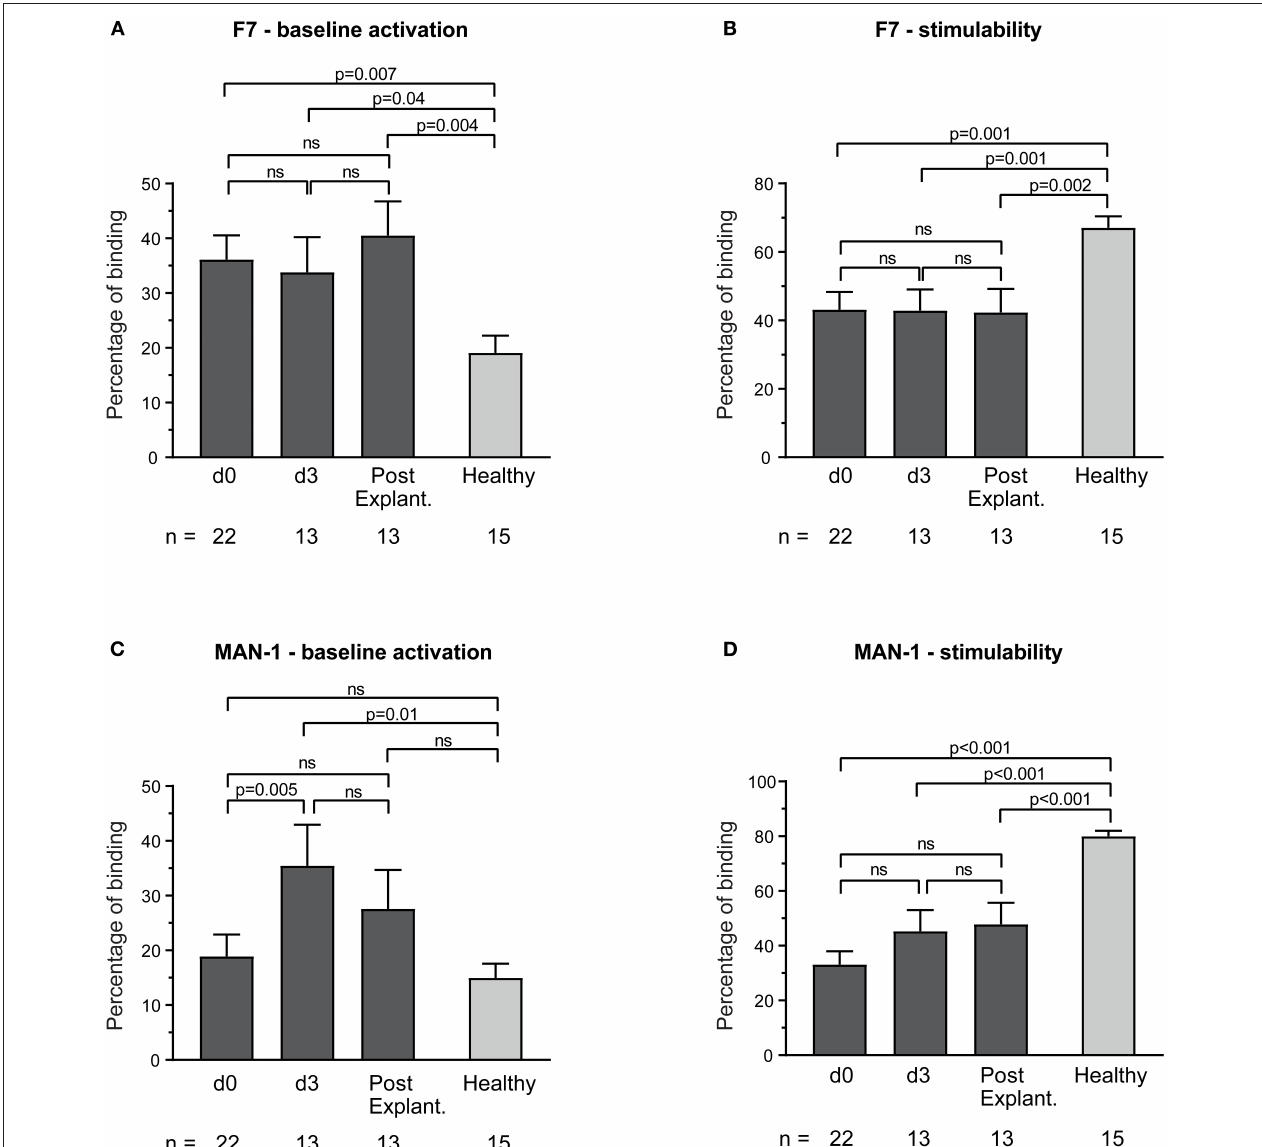
FIGURE 1 | Baseline monocyte activation and stimulability as determined by F7 binding (A,B) and MAN-1 (C,D) . The number of remaining patients analyzed at each time point during VA-ECMO therapy (d0, d3) and after explantation (post explant.) is presented below the individual bars. Baseline monocyte activation was measured in phosphate buffered saline treated samples. Stimulability was assessed in samples treated with phorbol 12-myristate 13-acetate to induce maximum monocyte activation. Binding of F7 and MAN-1 to CD14 + monocytes is presented in percentage and was quantified as described in the Materials and Methods section. Mixed effects models were used to analyze differences between means across different time points (d0, d3, and post explantation vs. each other). Unpaired t -tests were used to analyze differences of means at single time points. ns, not significant. Data are presented as mean ± SEM.